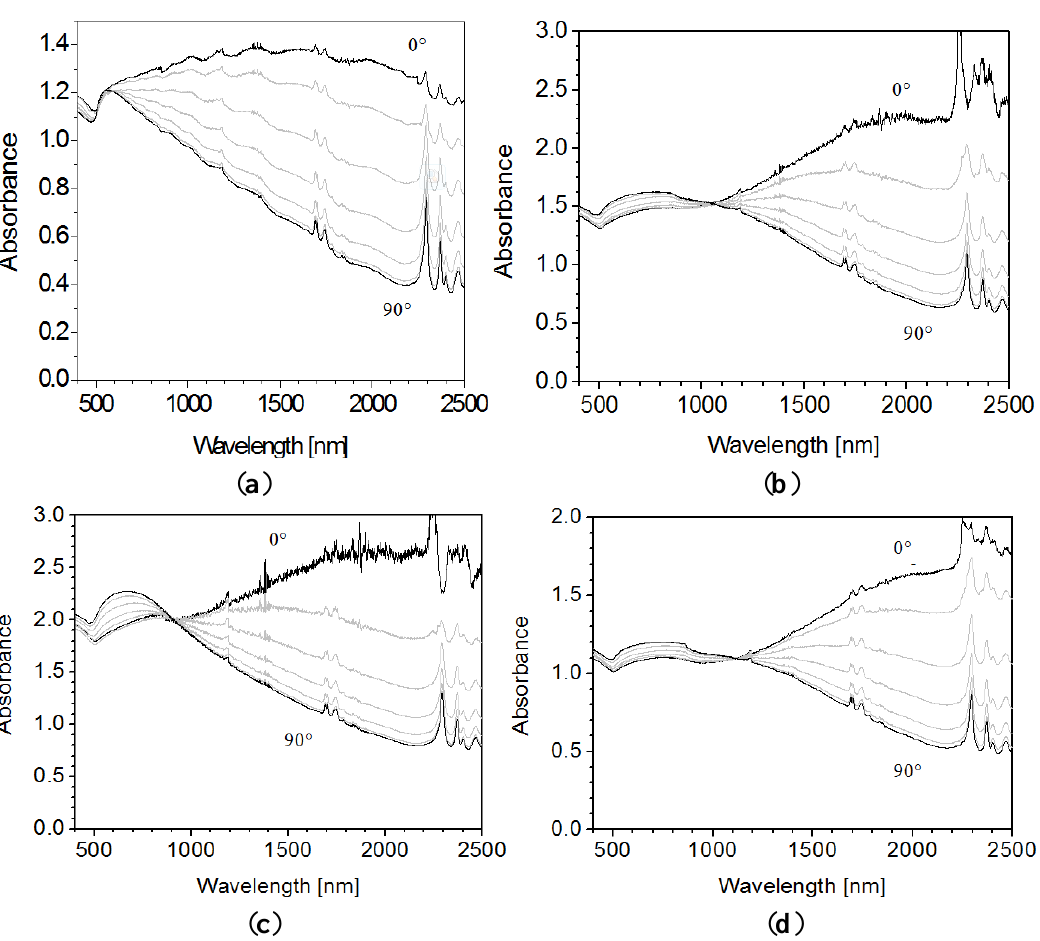
Figure 6. Vis-NIR spectra in polarized light of crosslinked PDMS films containing